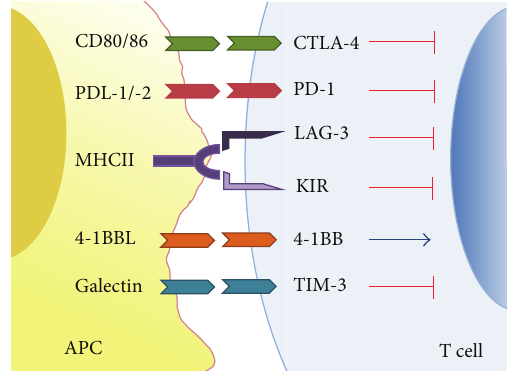
Figure 1: Negative and positive immune checkpoint receptors and ligands.